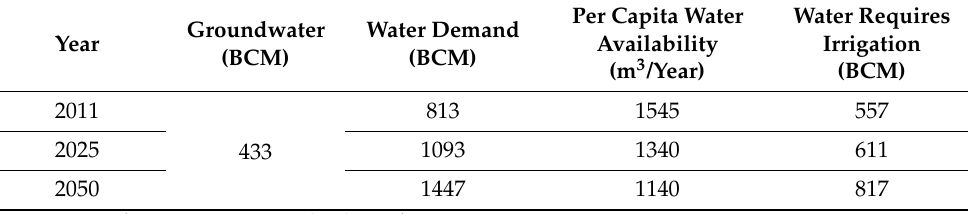
Table 1. In India water demand and availability (Report, NCIWRD,1999).